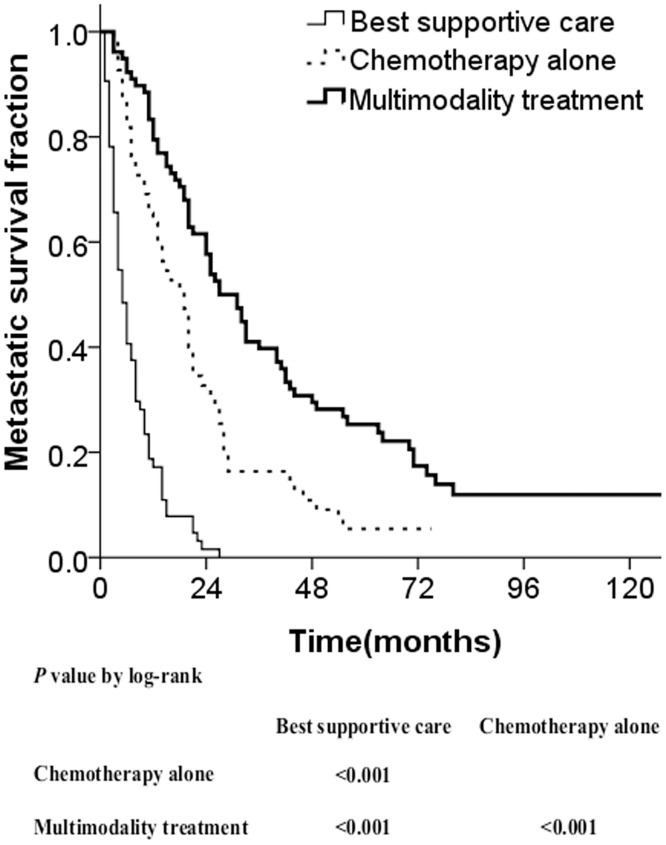
Metastatic survival curves stratified by treatment modality.